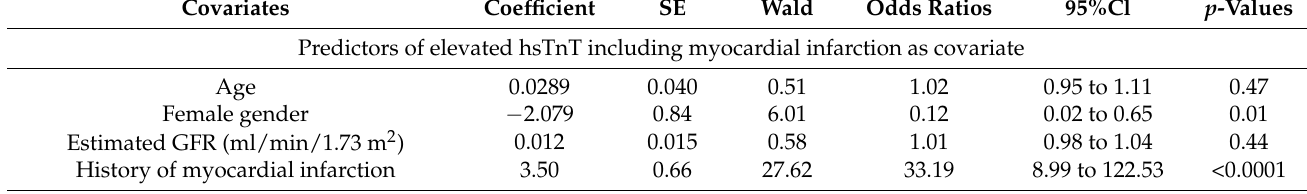
Table 2. Multivariable regression analysis regarding elevated levels of hsTnT and predictors of PCI.